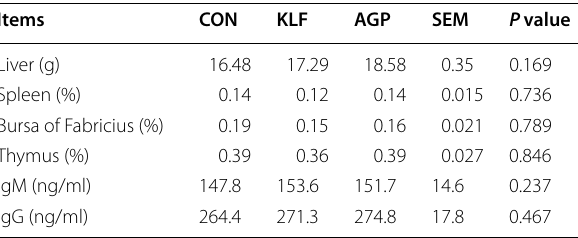
FI feed intake; BWG body weight gain; FCR feed conversion ratio; CON control treatment; KLF kudzu-leaf flavonoids supplement treatment; AGP the antibiotic supplement (Aureomycin) treatments a,b means within a row, different letters differed significantly ( P < 0.05) Table 3 Effects of kudzu-leaf flavonoids supplement on the immune organs and immune globulin content of Yellow- feathered